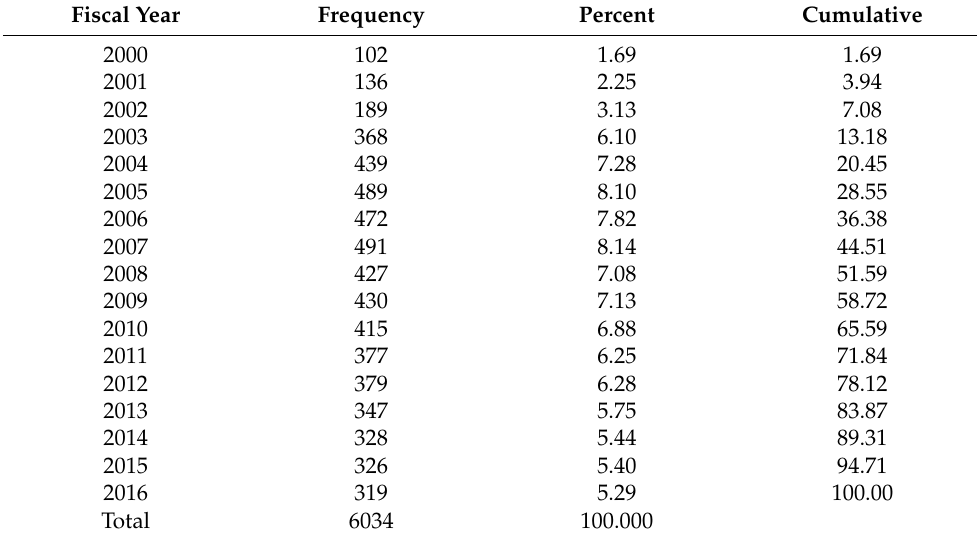
Table 1. Year-wise sample